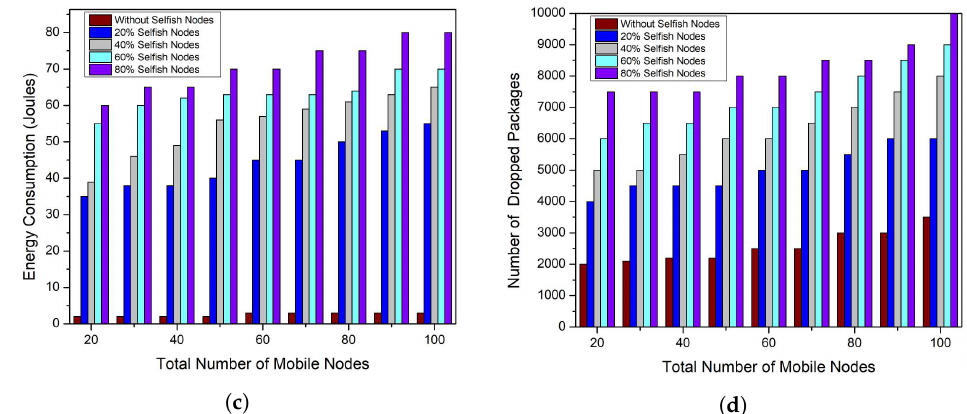
Figure 1. Influence of selfish nodes on all four performance metrics. ( a ) Package Delivery Probability; ( b ) Package Delivery Delay; ( c ) Average Energy Consumption; ( d ) Number of Dropped